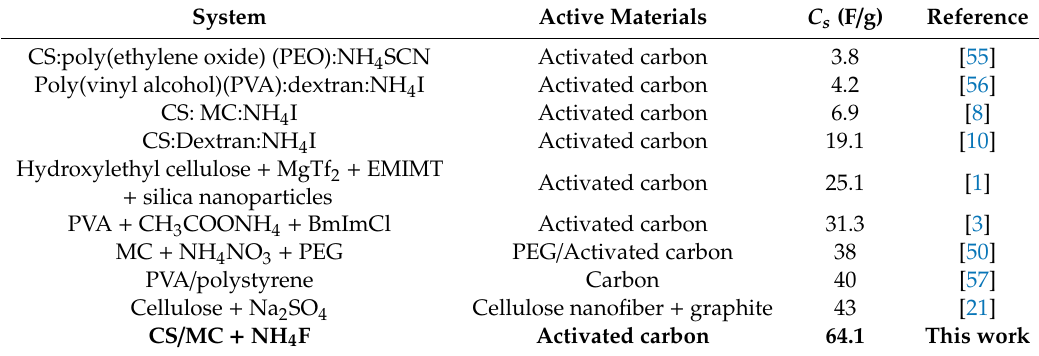
Figure 12. ( a ) Charge–discharge profile for the assembled EDLC at 0.2 mA/cm 2 , ( b ) specific capacitance of the assembled EDLC for 100 cycles. Table 3. EDLC studies with various active materials and their specific capacitances.